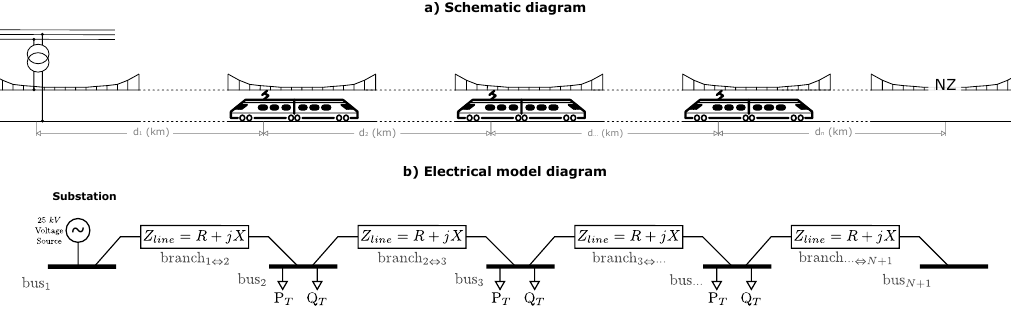
Figure 11. Framework for the increase of railway capacity: ( a ) illustration of physical representation; ( b ) considered bus-branch model for MatPower.